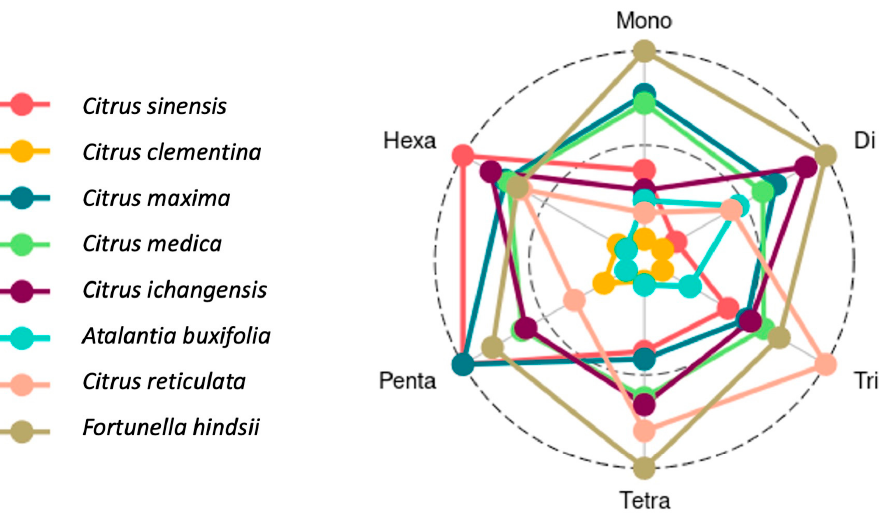
Figure 2. Distribution of SSR motifs in each of the Citrus species.